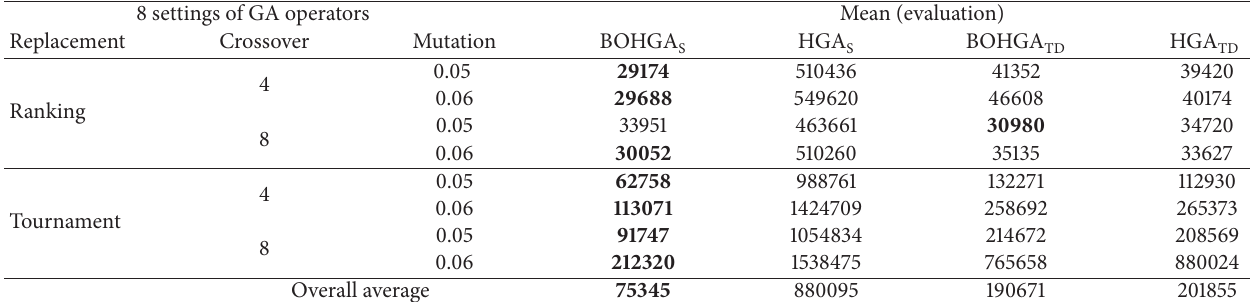
Figure 2: Surface of Rastrigin’s function: (a) 1-dimension; (b) 2-dimension. Table 1: Comparisons of BOHGA S , HGA S , BOHGA TD , and HGA TD in terms of mean number of evaluations under the eight settings of GA operators for the Rastrigin’s function in 20 dimensions by stopping rule